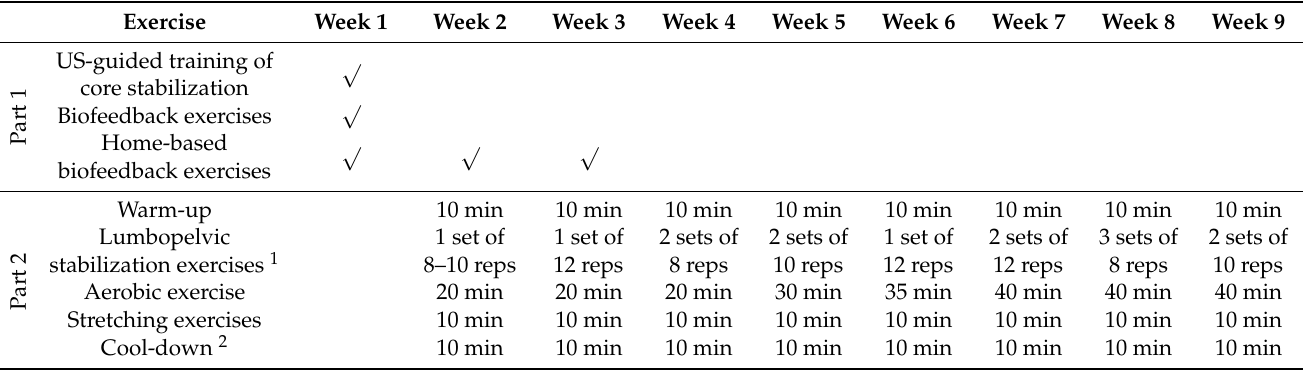
Table 1. Supervised ‘Physio-EndEA’ exercise intervention